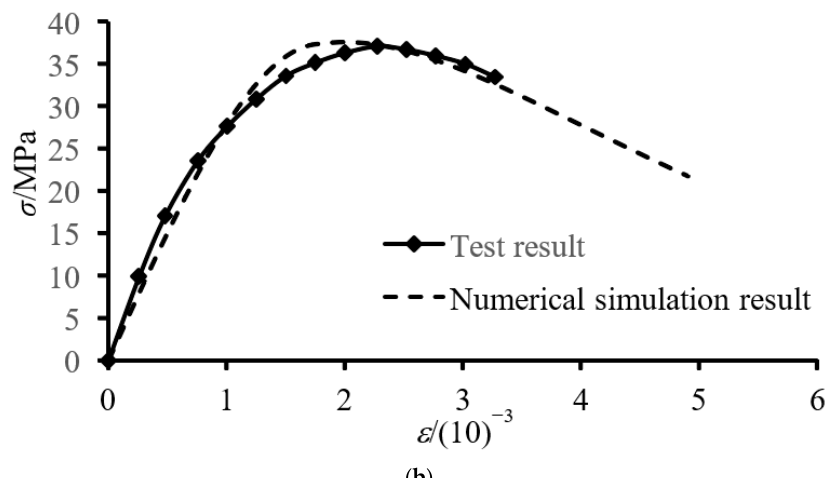
Figure 3. Comparison of numerical simulation result and experimental result (biaxial stress test). ( a ) σ 1 / σ 2 = − 1:0; ( b ) σ 1 / σ 2 = − 1: − 1. Table 3. Simulation parameters of biaxial stress test.